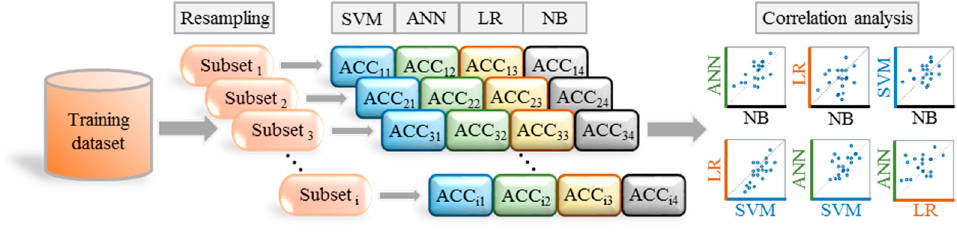
Figure 6. The flowchart of the resampling strategy and correlation evaluation. ACC: accuracy.